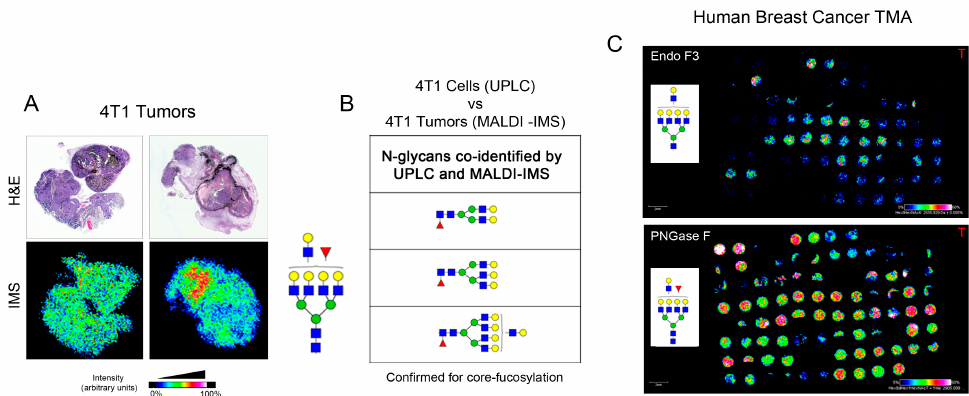
Figure 4. N ‐ glycan MALDI ‐ IMS of 4T1 tumor and human breast TMA. ( A ) A total of 1 × 10 5 cells